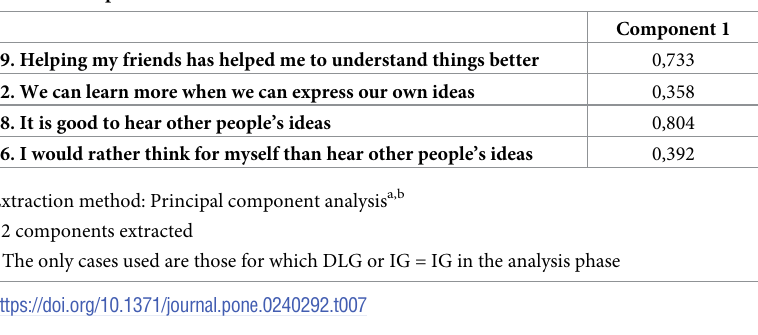
Table 7. Component matrix for IGs a,b